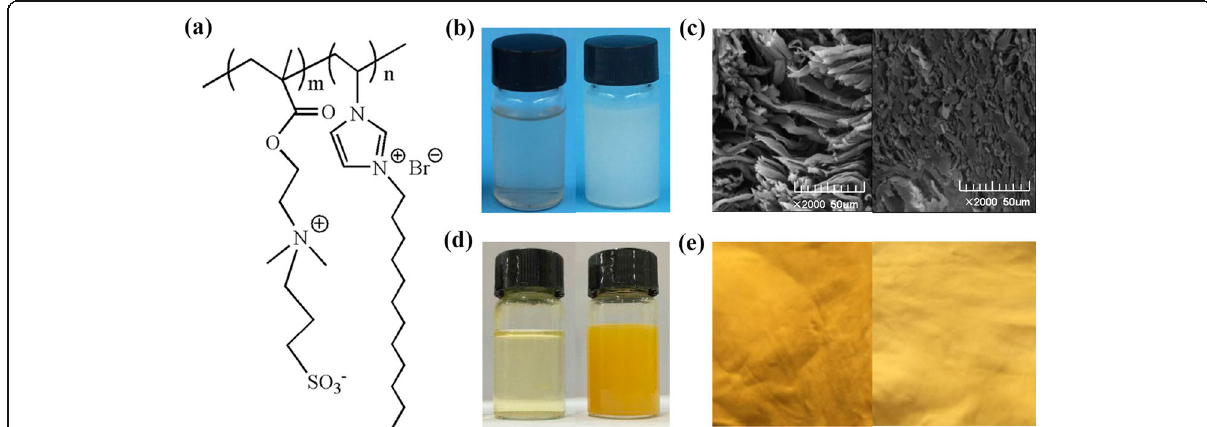
Fig. 5 a The structure of liquid-based fatliquor, p (DM-co-[DDVIM]Br)PS; b absorption of the fatliquoring agent, left: p (DM-co-[DDVIM]Br) PS, right: commercial fatliquor; c looseness of fatliquored leather, left: with p (DM-co-[DDVIM]Br)-PS, right: without any fatliquor; d absorption of dyeing; and e color of dyed leather, left: with p (DM-co-[DDVIM]Br) PS, right: with commercial fatliquor [11]. Copyright @ 2020,